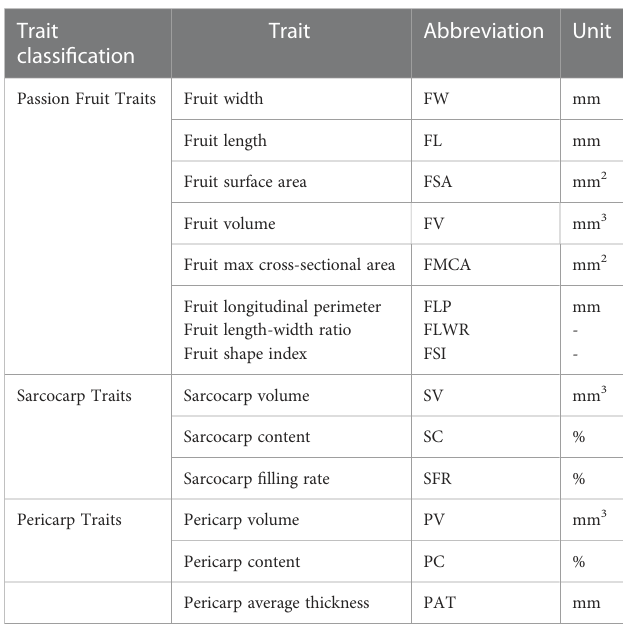
TABLE 1 The classi fi cation and abbreviation of passion fruit traits. Trait classi fi cation Passion Fruit